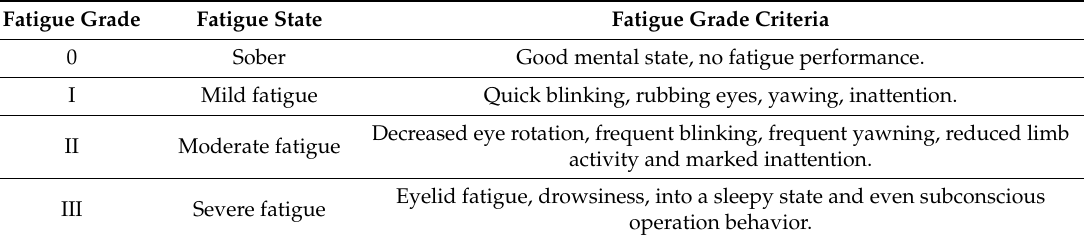
Table 1. Fatigue level and evaluation criteria.